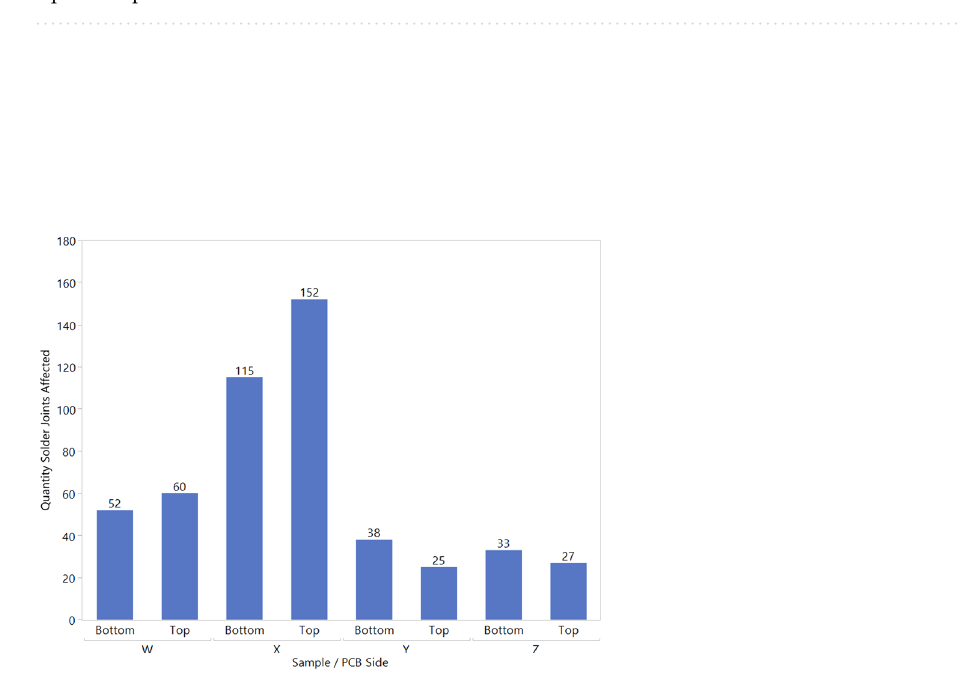
Figure 3. Photograph ( a ) and infrared thermography image ( b ) during the rework process for sample Z (with a square-shaped heat shield.